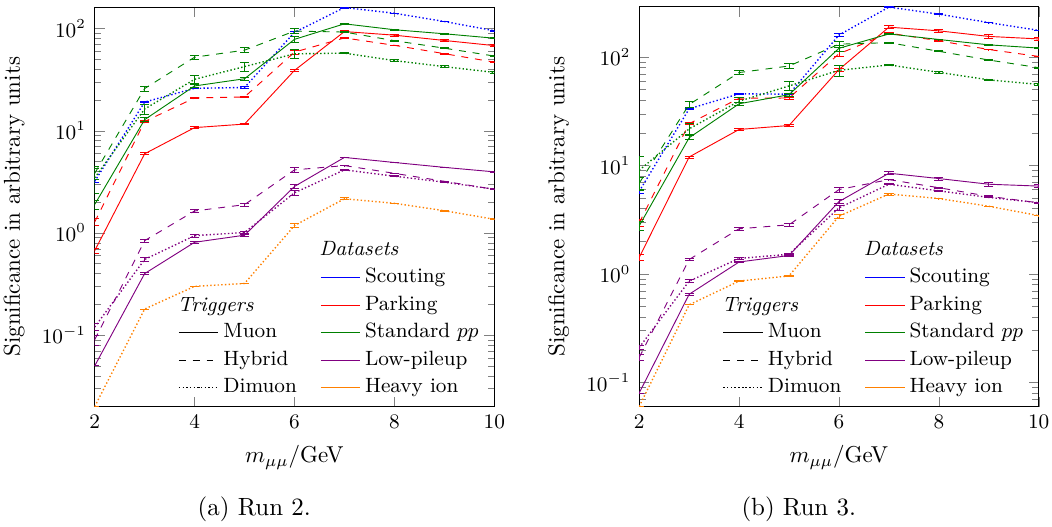
Figure 6 : Comparison of the significance to discover the displaced low- p as a function of the dimuon invariant mass. The comparison between the relevant datasets and trigger scenarios for Run 2 and Run 3 are shown in panels (a) and (b),